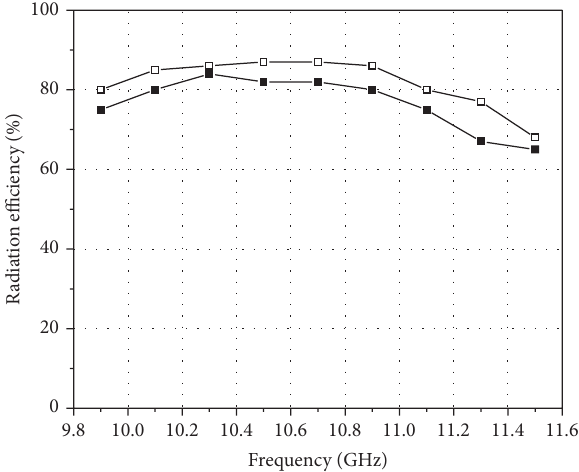
Figure 11: Measured and simulated radiation efficiency versus